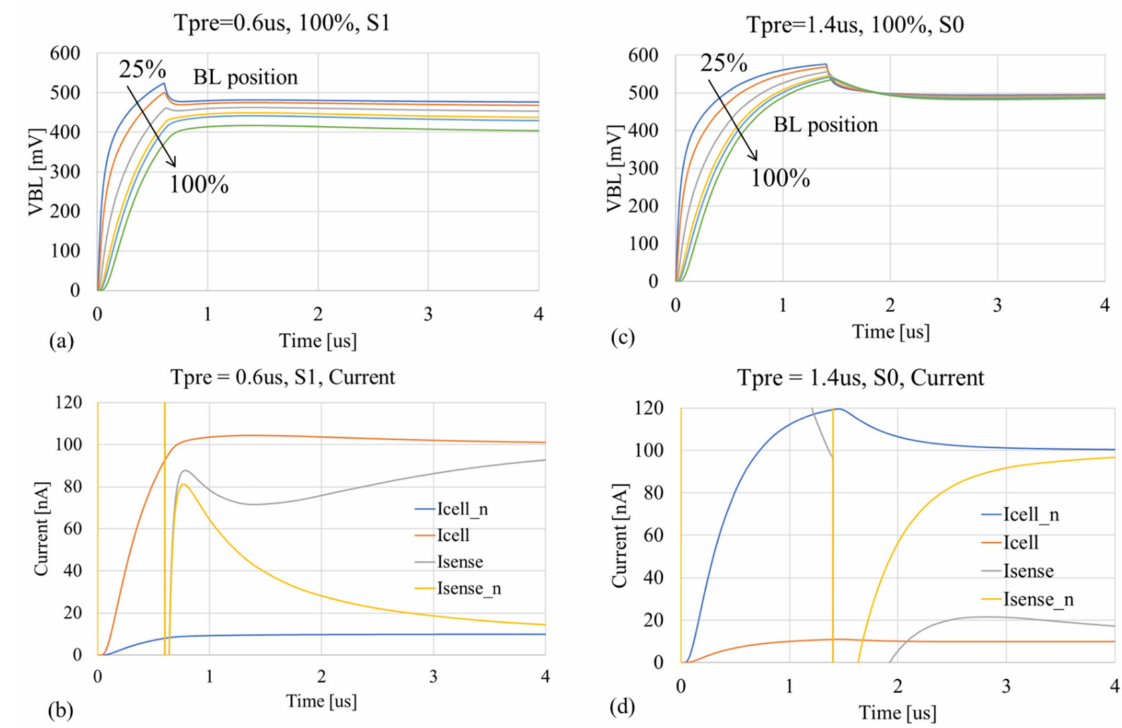
Figure 11. Voltage ( a ) and current ( b ) waveforms when the farthest “1” cell is selected with Tpre = 0.6 us and the worst data pattern of 010. Voltage ( c ) and current ( d ) waveforms when the slowest “0” cell is selected with Tpre = 1.4 us and the worst data pattern of 101.